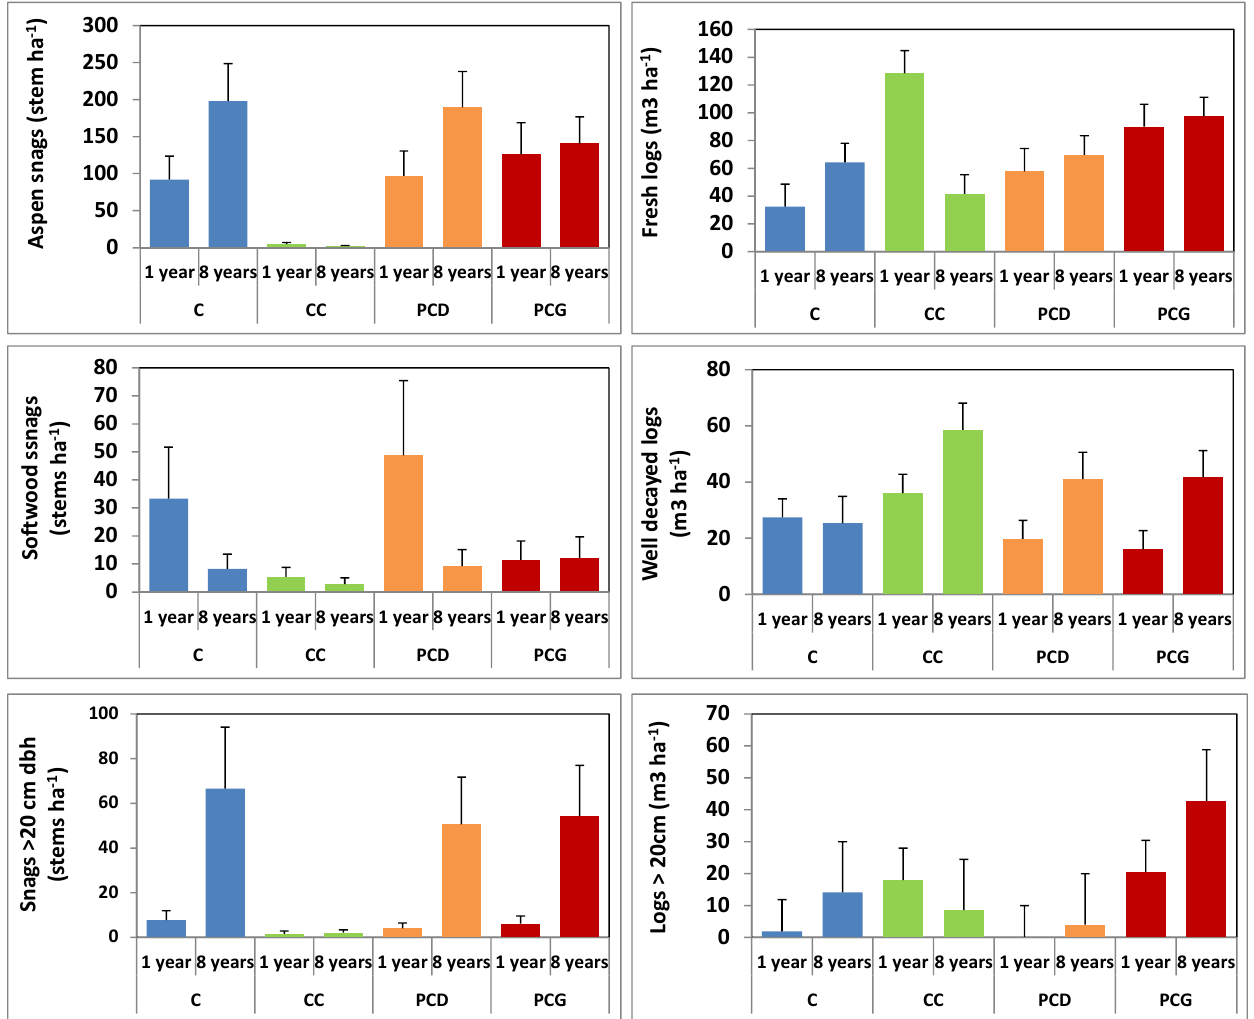
Figure 5. Snag density and downed log volume immediately and eight years following partial and clear cut harvesting of mixed boreal stands. C: control stands; CC: clear cut; PCD: partial cut—dispersed; PCG: partial